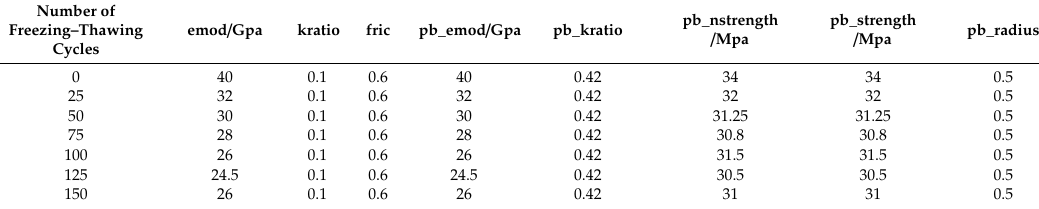
Table 4. Meso-parameters of cement aggregate bonding of the damaged